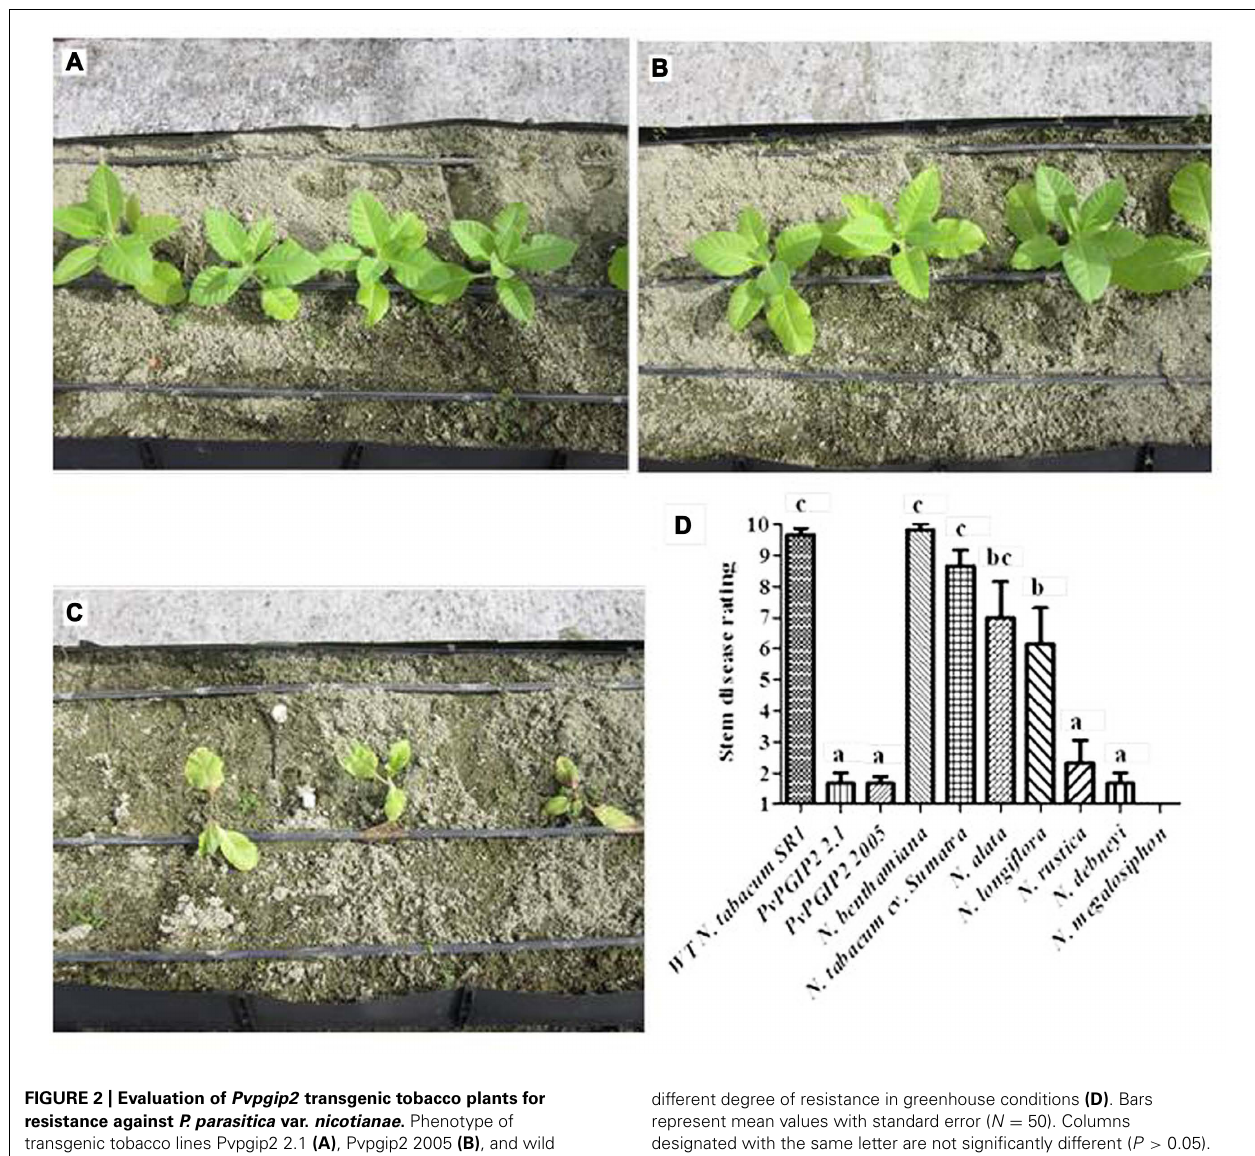
different degree of resistance in greenhouse conditions (D) . Bars represent mean values with standard error ( N = 50). Columns designated with the same letter are not significantly different ( P > 0.05). The photographs were obtained at 100 cm of distance and are representative of one typical event. Nicotiana rustica (PI 499174), Nicotiana alata (PI 42334), Nicotiana longiflora (PI 555533), Nicotiana benthamiana (PI 555478), Nicotiana debneyi (PI 503320), Nicotiana megalosiphon (PI